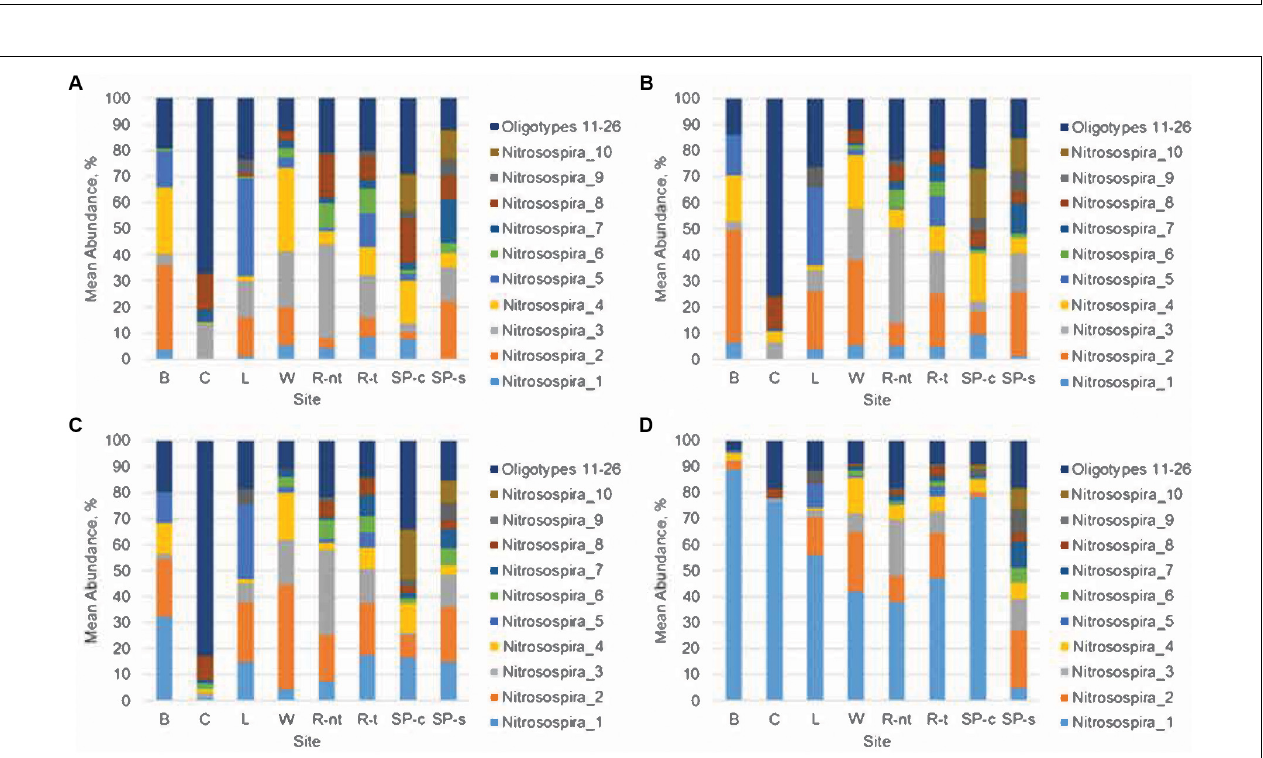
FIGURE 4 | Distribution of oligotypes within the genus Nitrosospira . (A) Initial sampling, prior to treatment, (B) no urea amendment, day 21, (C) 100 µ g N g − 1 soil amendment, day 21, (D) 500 µ g N g − 1 soil amendment, day 21. Sampling sites include Becker (B); Crookston (C); Lamberton (L); Waseca (W); Rosemount (non-tilled, R-nt); Rosemount (tilled, R-t), St. Paul (corn, SP-c), and St. Paul (soybean, SP-s).